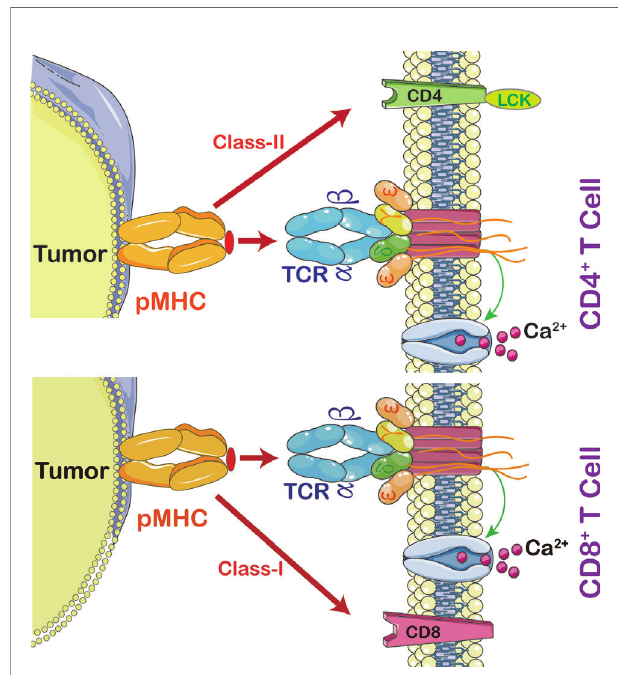
FIGURE 2 | The interaction between peptide MHC and T cells. Cytotoxic T cells (CD8 + ) recognize MHC-I, CD3 coupled TCRs which activate T cell signaling cascade, including calcium-dependent and protein kinase C signaling pathways (PKC). Calcium is required for activation of nuclear factor of activated T cells (NFAT) leading to expression and secretion of Interleukin (IL)-2 and activation of PKC leading to tuning and regulating the production and secretion of ILs, including IL-2, T cell migration, T cell proliferation, and autoimmunity and graft rejection. CD4 + T cells are able to switch off the immune system by promoting regulatory T cells (Treg). In order to activate T cell proliferation, TCR also triggers p38MAPK and PI3K/Akt pathways. Once CD4 or CD8 activates TCR, it then activates Lymphocyte-Speci fi c Protein- Tyrosine Kinase (Lck) which triggers phosphorylation of CD3 z